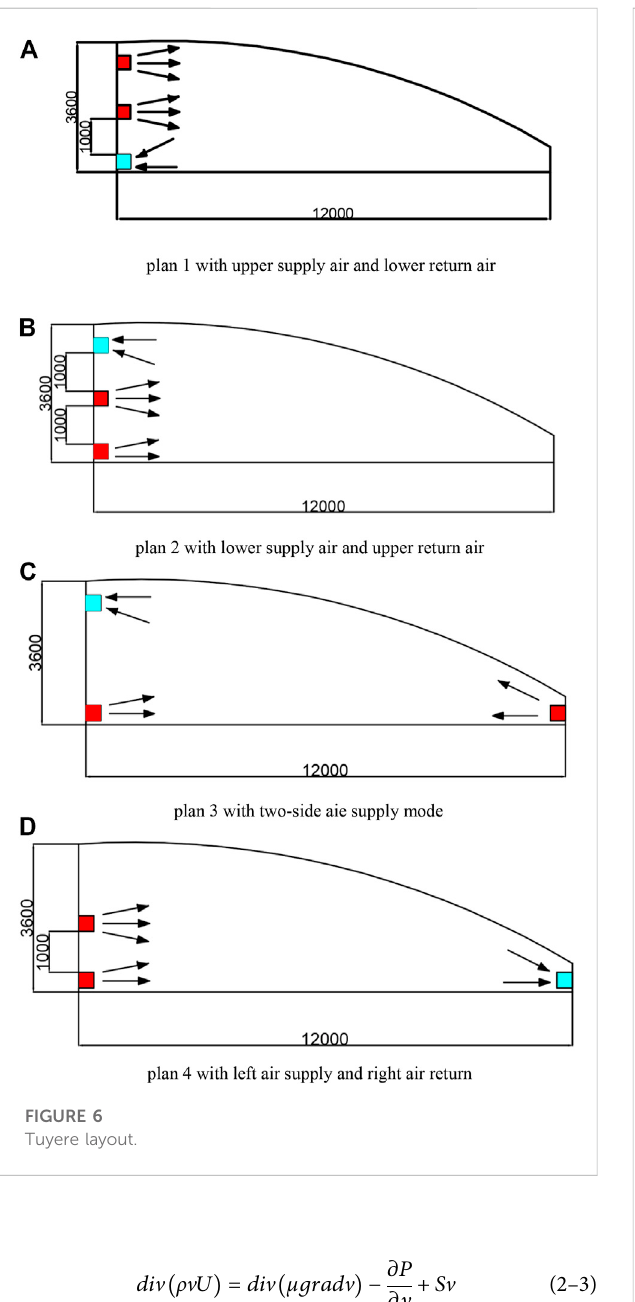
FIGURE 6 Tuyere